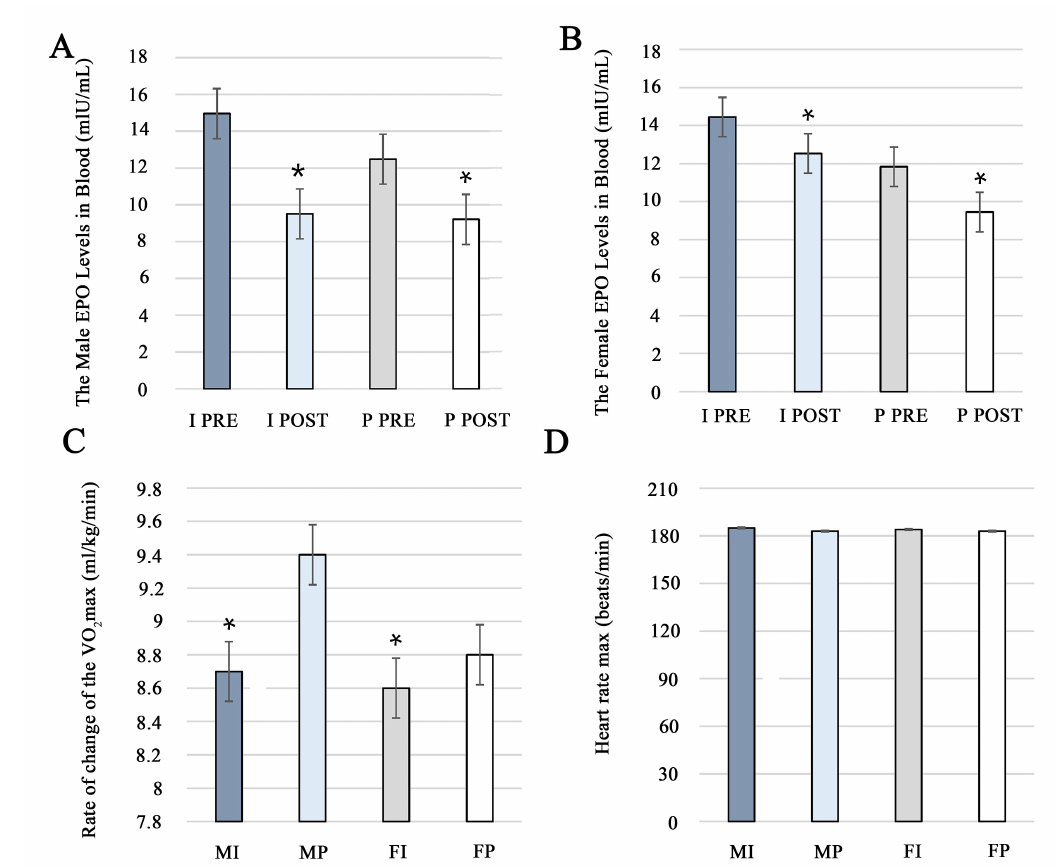
Fig. 2. Effect of natural iron supplement no the exercise capacity. (A) The EPO Levels in Blood (Male). (B) The EPO Levels in Blood (Female). (C) Rate of change of the VO 2 max. (D) HRmax. I PRE, Iron pre-test; I POST, Iron post-test; P PRE, Placebo pre-test; P POST, Placebo post-test; MI, Male iron; MP, Male placebo; FI, Female iron; FM, Female